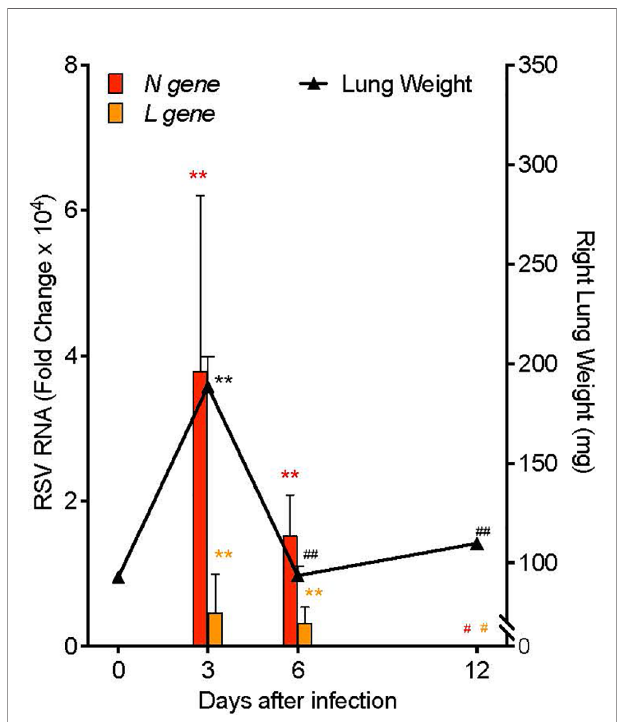
FIGURE 2 | Mouse RSV pneumonia resolves spontaneously. Mice were infected with 10 5 PFU of the RSV Line19 strain. Left axis: RSV N gene and L gene viral RNA expression in left lung tissue. Right axis: weight of right lung. Values are mean of n=3-4 per time point ± SEM and are representative of 2 separate experiments. ** p < 0.01 vs Day 0, # p ≤ 0.05 vs Day 3, ## p < 0.01 vs Day 3 by One-way ANOVA with Holm-Sidak ’ s multiple comparison correction.